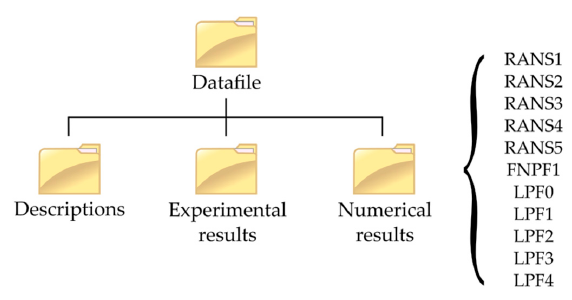
Figure A1. Directory structure of the Supplementary Materials. Figure A 1. Directory structure of the supplementary material. Figure A 1. Directory structure of the supplementary material.